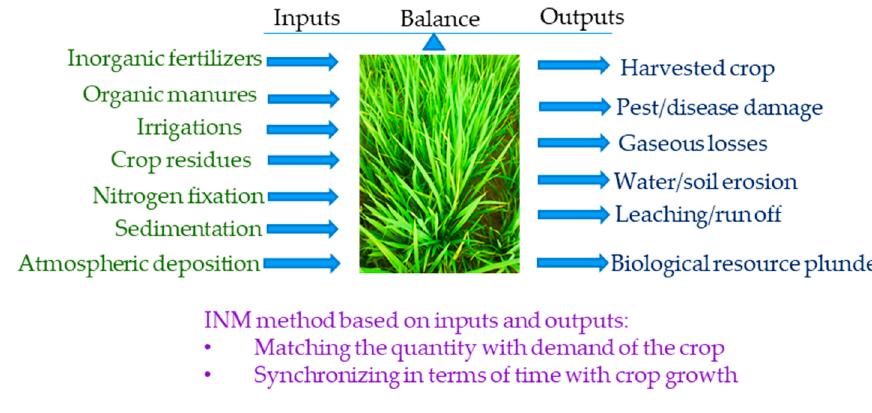
Figure 3. Mean of nutrients for inputs and outputs, and the principles of integrated nutrient management systems [22,23].